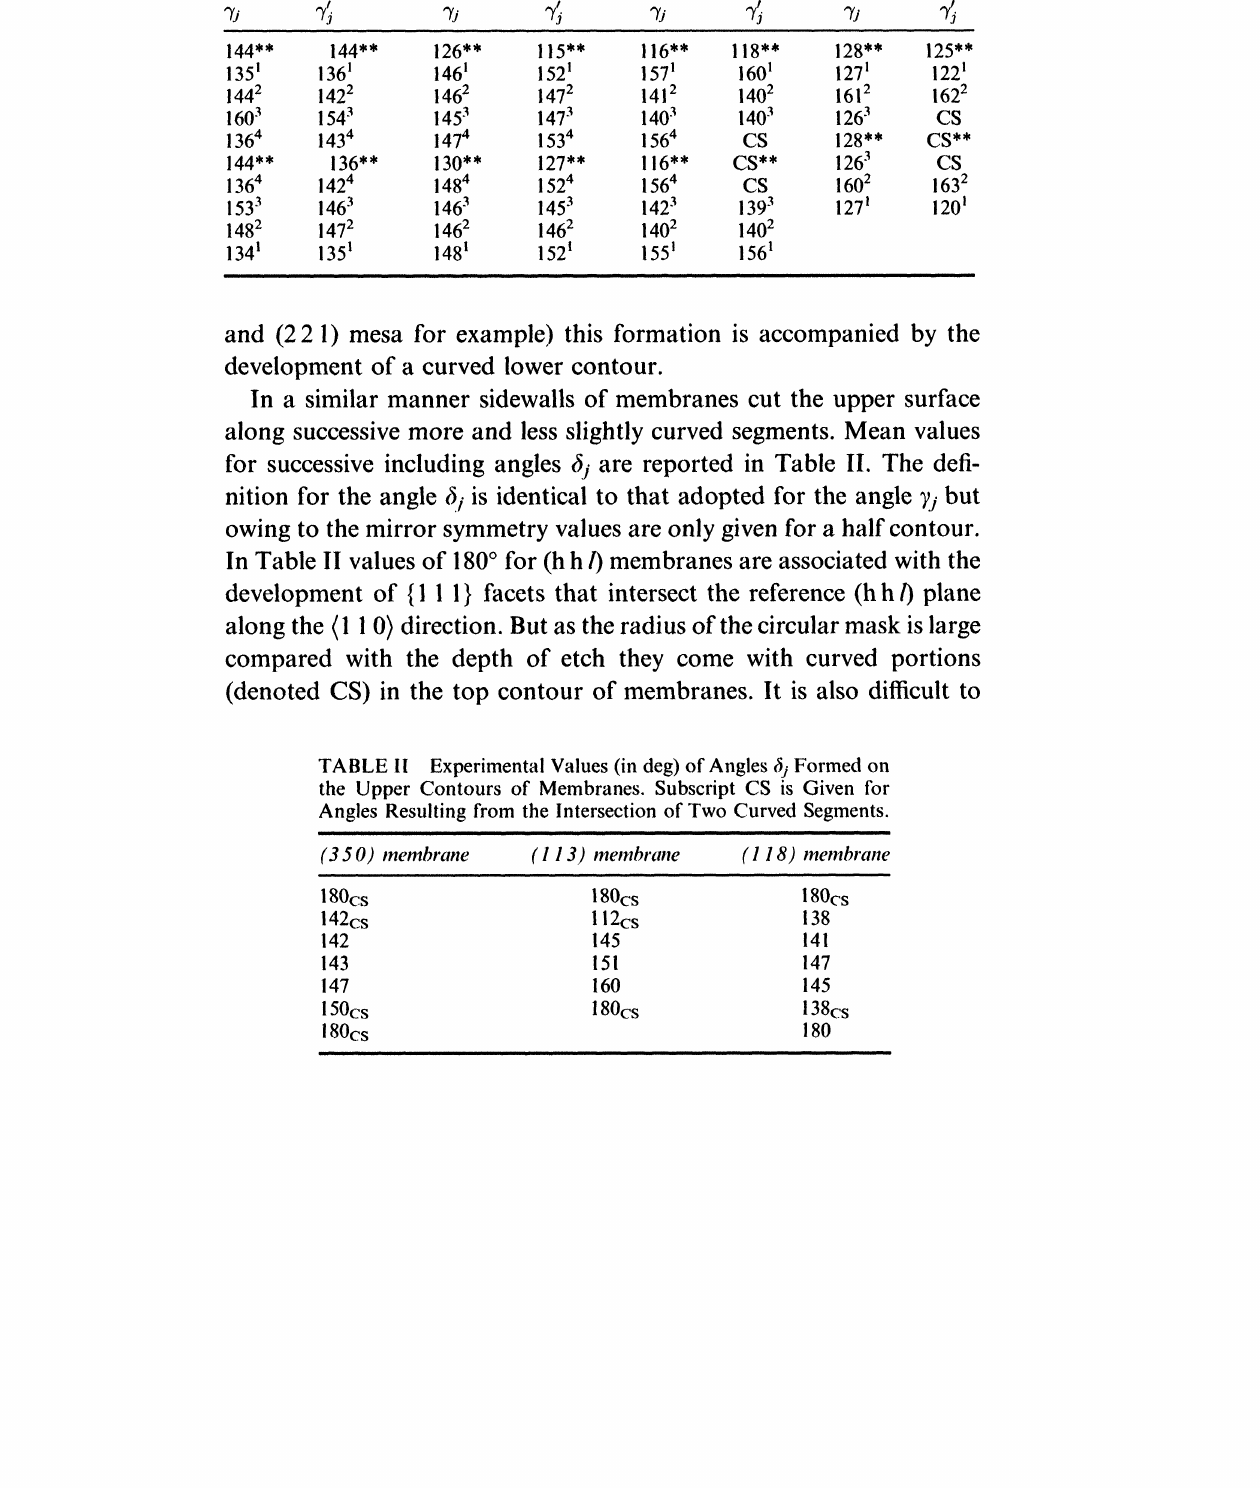
Experimental Values (in deg) of Angles Yi and ),’ Formed on the Upper (),j) and Lower (),’) Contours of Mesa. CS Denotes a Curved Contour for Which it is Im- y. ** Correspond to Angles Whose Bisectrix is the (I 10) possible to Dfine Angles Direction. (350) mesa